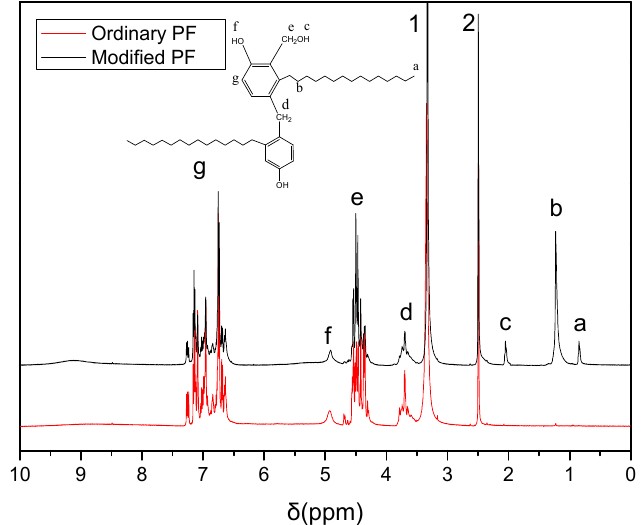
Figure 2. The 1 H NMR spectra of the ordinary PF and modified PF (the amount of 3-pentadecyl-phenol is 15% of the total amount of phenol).